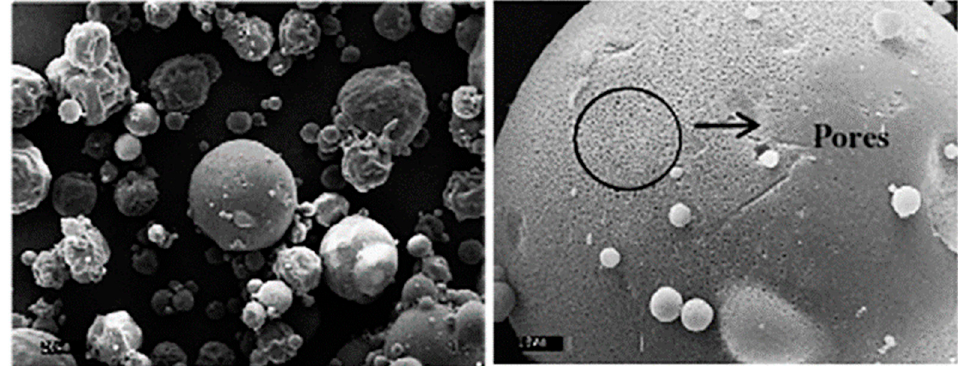
Figure 6. Porous sphere after the spray freeze drying process. The figures are reused with permission from Elsevier [62].